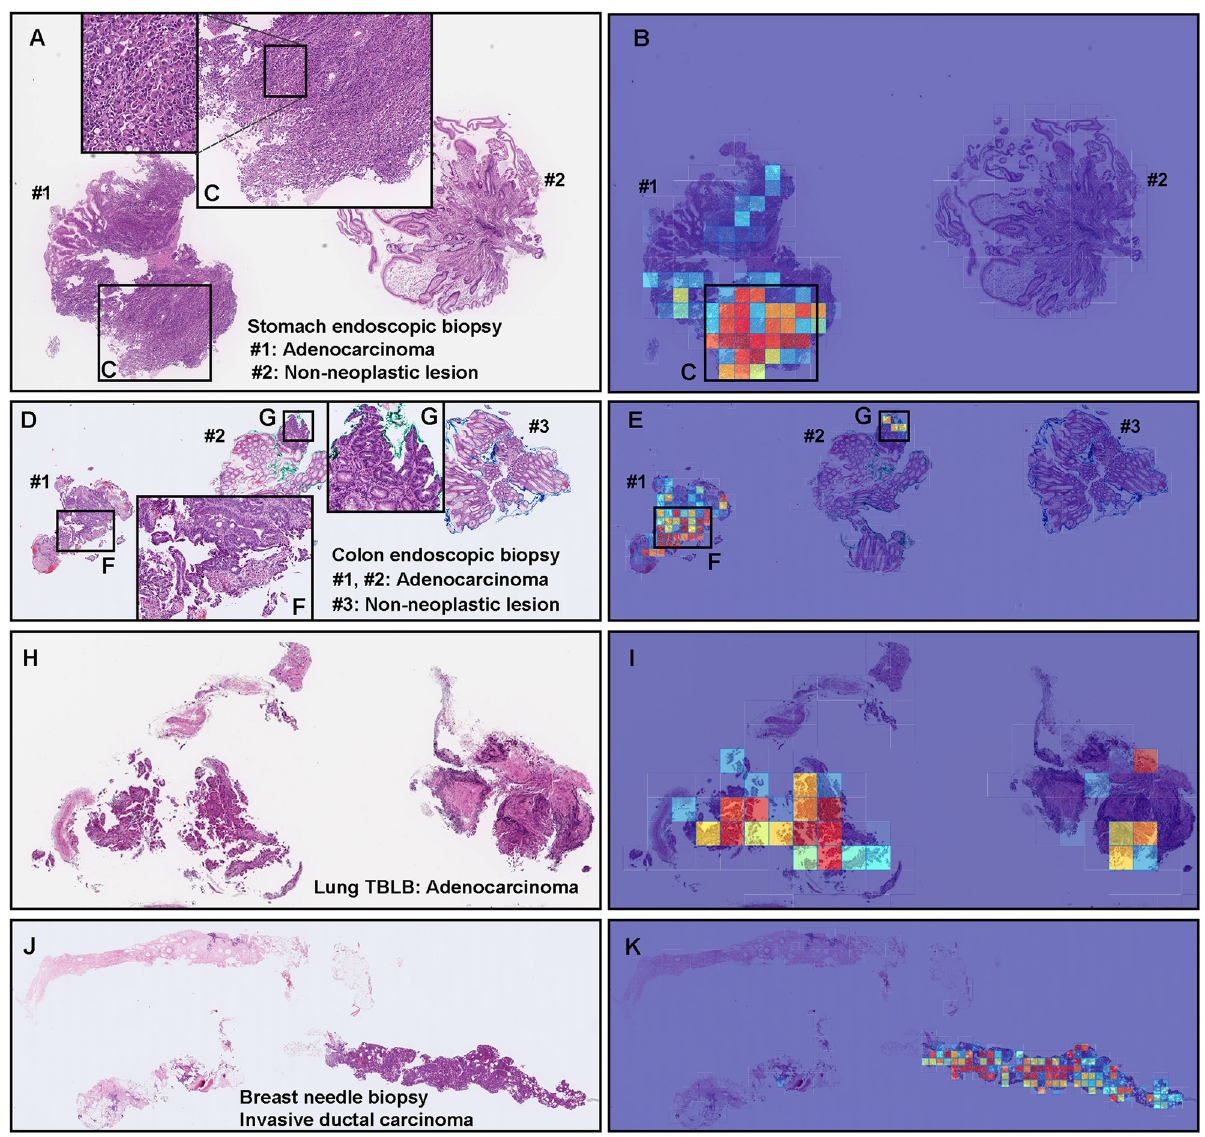
Fig 3. Representative true positive adenocarcinoma classification of stomach, colon, lung, and breast biopsy test cases using the model (WS-4K: 224, x10 EfficientNetB1). In the adenocarcinoma whole slide images (WSIs) of stomach endoscopic biopsy (A), colon endoscopic biopsy (D), lung transbronchial lung biopsy (TBLB) (H), and breast core needle biopsy (J) specimens, the heatmap images show true positive prediction of adenocarcinoma cells (B, E, F, G, I, K) which correspond respectively to H&E histopathology (A, C, D, F, G, H, J). The heatmap images show true negative predictions of non-neoplastic tissue fragments (#2 in (B) and #3 in (E)) and true positive predictions of adenocarcinoma tissue fragments (#1 in (B) and #1-#2 in (E)) which correspond respectively to H&E histopathology of adenocarcinoma area (C, F, G). The heatmap uses the jet color map where blue indicates low probability and red indicates high